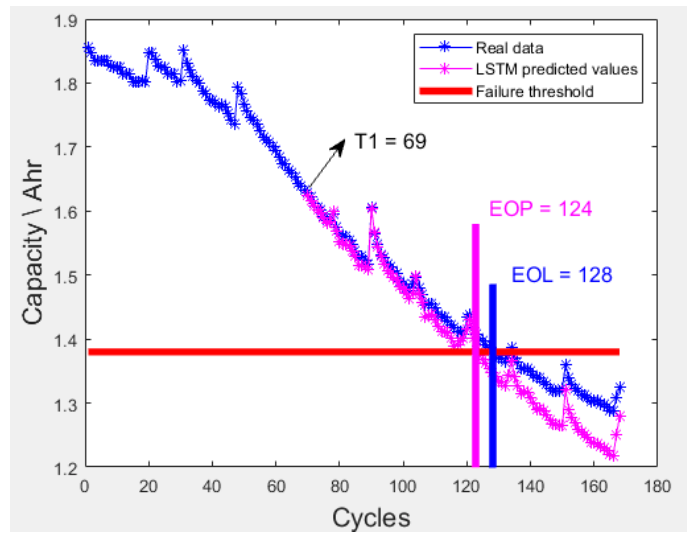
Figure 8. The prediction result of LSTM at T1 = 69.